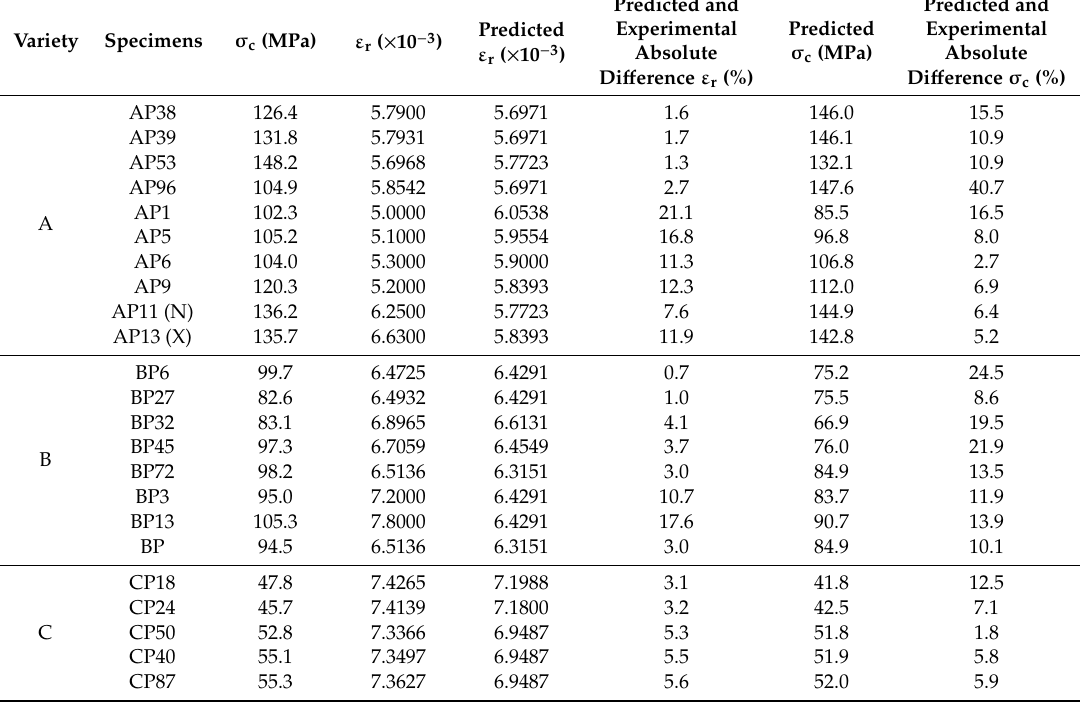
Table 4. Values of mechanical data and mechanical properties of sandstones